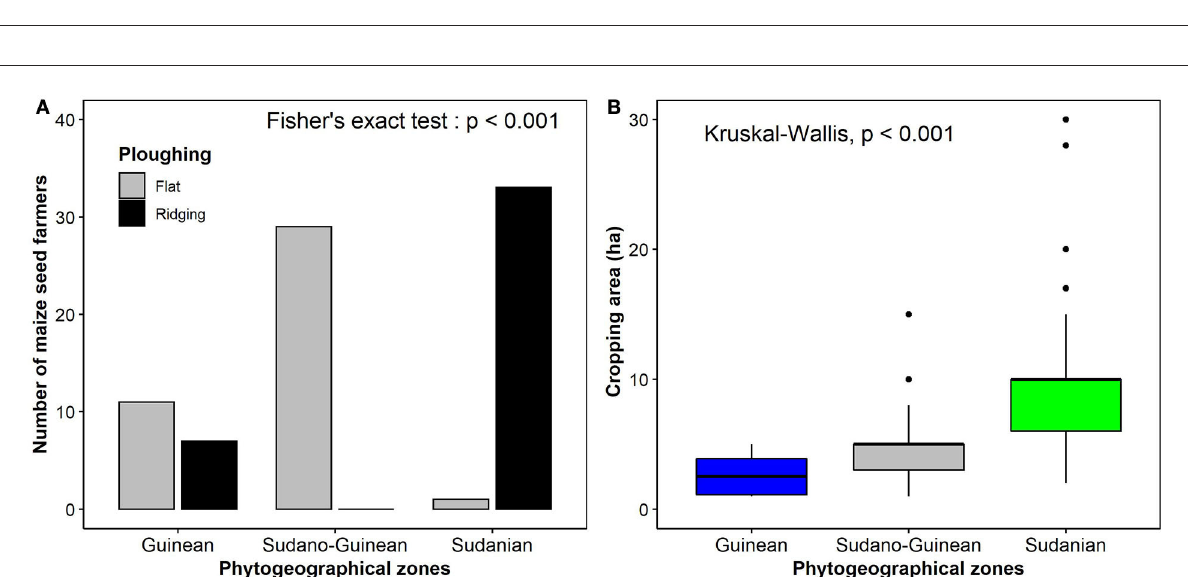
FIGURE5 Type of plowing (A) and cropping area (B) used by maize seed producers in each phytogeographical zone.